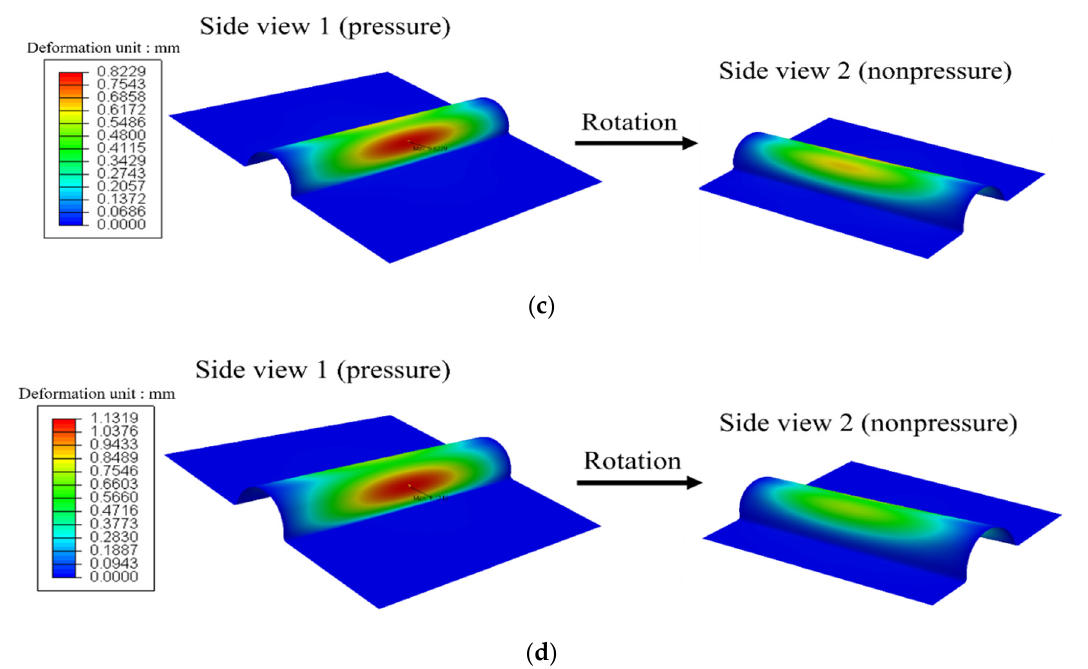
Figure 11. Deformed SPB shapes of 82.8° fillet angle under asymmetric pressure in ( a ) case No. 12, ( b ) case No. 22, ( c ) case No. 32, and ( d ) case No. 42.